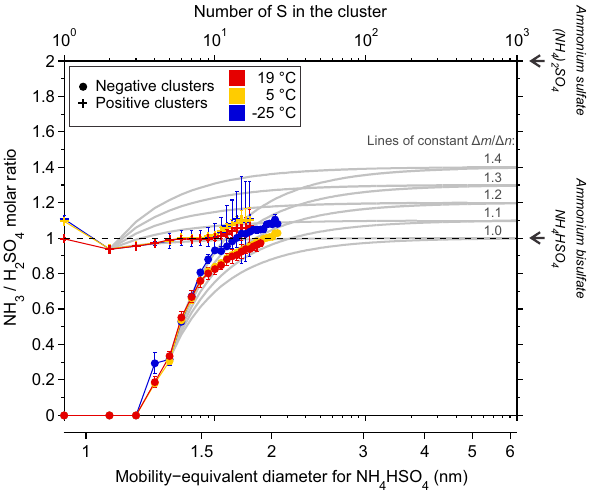
Figure 9. The average measured NH 3 /H 2 SO 4 molar ratio in the negatively and the positively charged NH 3 –H 2 SO 4 clusters, plotted against cluster size, which is approximated by the num- ber of S atoms in the clusters. The secondary abscissa shows the corresponding mobility-equivalent diameter for these clusters, assuming an NH 3 /H 2 SO 4 molar ratio = 1 and a density of 1780kgm − 3 (i.e., ammonium bisulfate). An NH 3 /H 2 SO 4 molar ratio = 2 would correspond to ammonium sulfate. The presented data are uncertainty-weighted averages over the observations from the CLOUD chamber experiments in the respective conditions that yielded the maximum NH 3 content in the clusters at three different temperatures. Shown as grey curves are calculated results assuming growth following a constant (cid:49)m/(cid:49)n , starting from the observed average m at n = 4 (anions) or n = 2